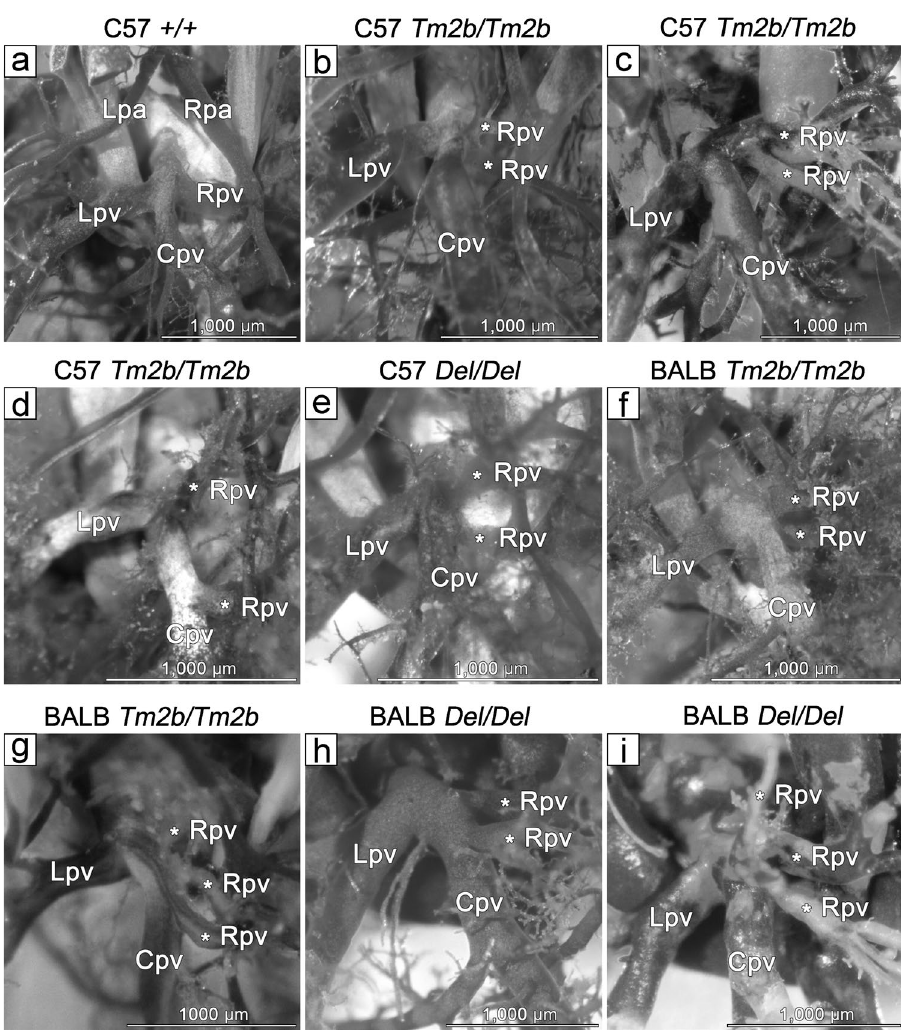
(Fig. 7j–l). CECR2 protein expression in forming glomeruli at E18.5 was confirmed using immunofluorescence with a CECR2-specific antibody (Fig.